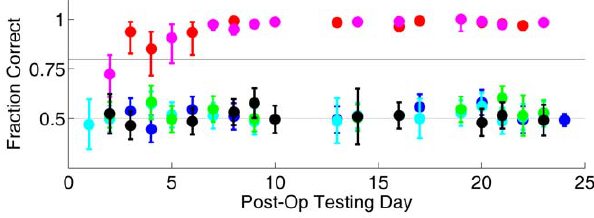
Figure 3. Performance on visual tasks after V1 lesion. Post- operative performance of subject S1, whose pre-operative performance is shown in Figure 2. Symbols and error bars as defined in Figure 2. In addition, motion discrimination was tested with 95% coherent motion (cyan) post-lesion. Performance fell to chance for motion discrimination tasks (cyan, green), image discrimination (blue) and orientation discrimination (black), yet was spared for the tasks requiring approaching a salient visual target (red, magenta).